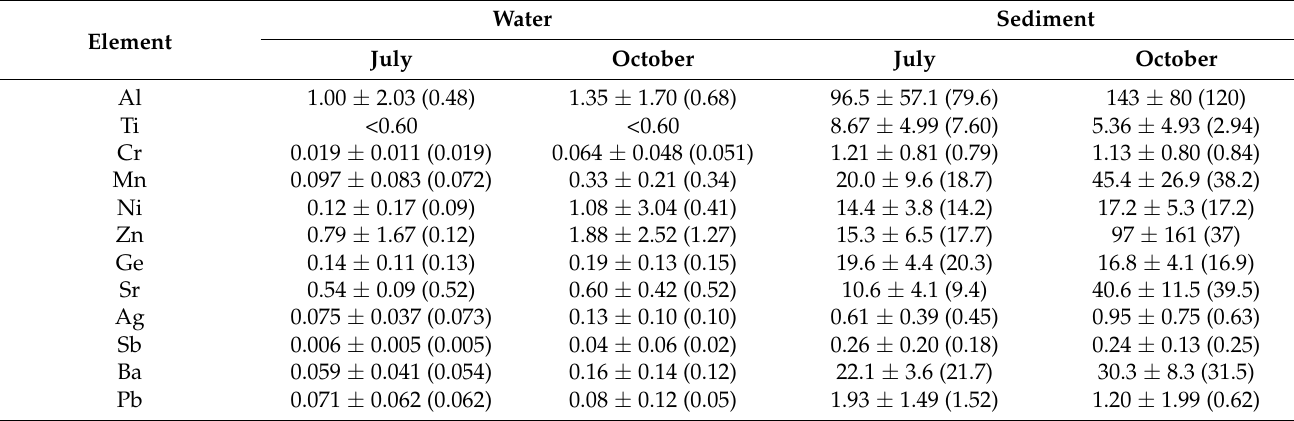
Table 2. Averages of water-soluble elements’ concentrations in water (mg L − 1 , n = 44) and sediment ( µ g g − 1 , n = 14) samples from Podu Iloaiei Dam Lake, north-eastern Romania. Data are presented as mean ± stdev (median). Element